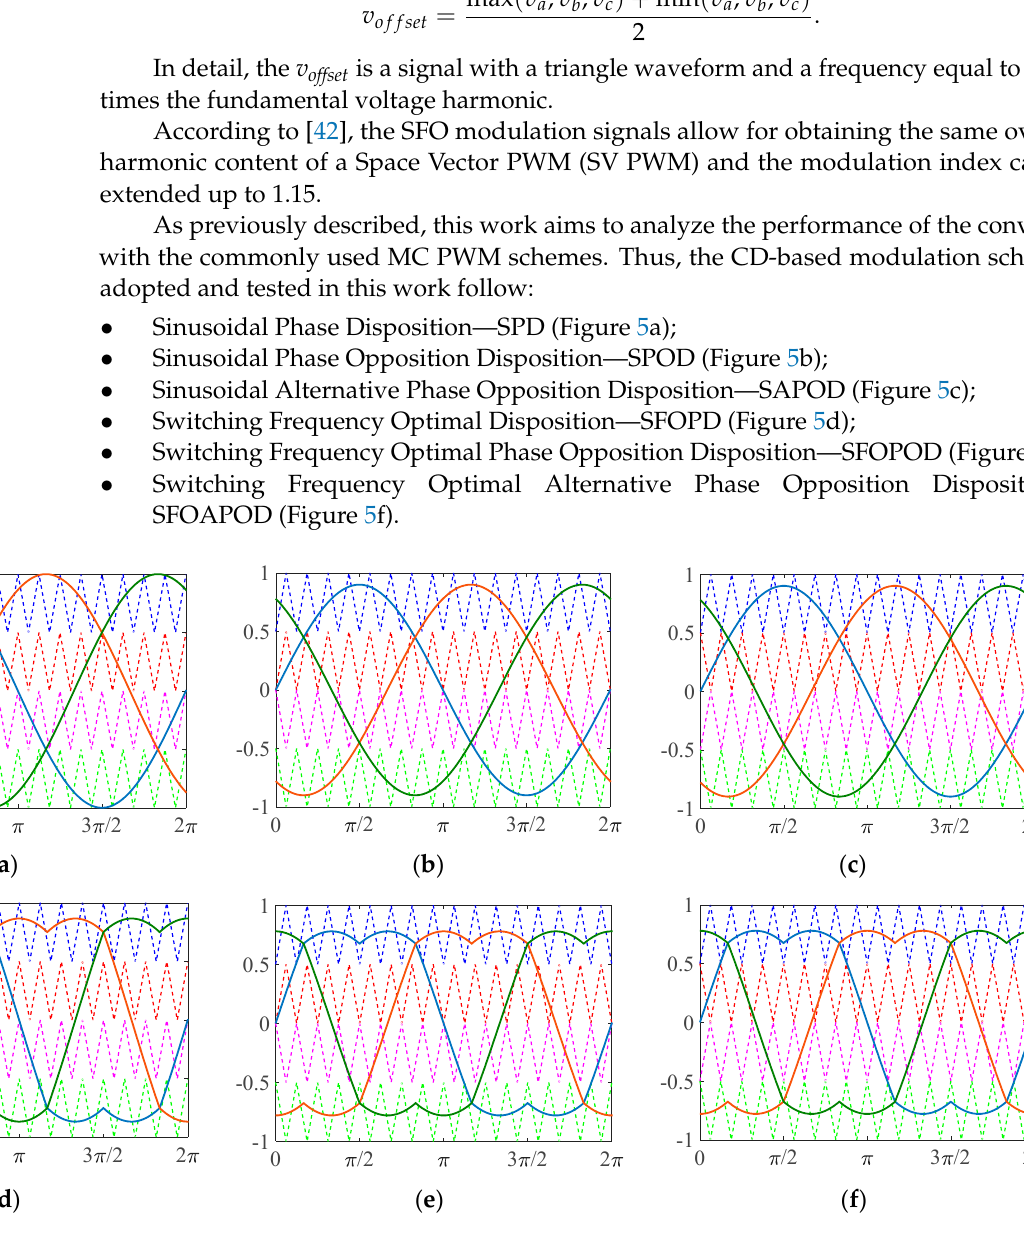
Figure 5. Carrier ‐ disposition ‐ based modulation schemes: ( a ) Sinusoidal Phase Disposition—SPD; ( b ) Sinusoidal Phase Opposition Disposition—SPOD; ( c ) Sinusoidal Alternative Phase Opposition Disposition—SAPOD; ( d ) Switching Frequency Optimal Phase Disposition—SFOPD; ( e ) Switching Frequency Optimal Phase Opposition Disposition—SFOPOD; ( f ) Switching Frequency Optimal Alternative Phase Opposition Disposition—SFOAPOD.